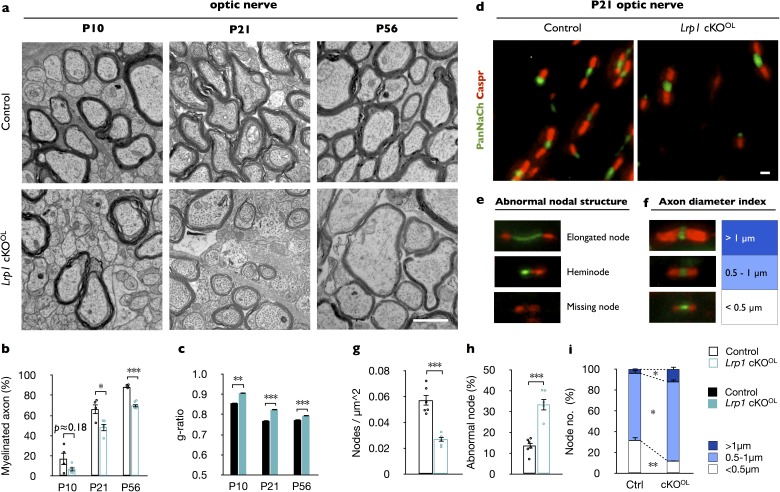
Lrp1 ablation in the OL-lineage leads to hypomyelination and nodal defects.(a) Ultrastructural images of optic nerve cross-sections from P10, P21, and P56 control and Lrp1flox/flox;Olig2-Cre conditional knockout mice (Lrp1 cKOOL). Scale bar = 1 µm. (b) Quantification of myelinated axons in the optic nerve of Lrp1 control and cKOOL mice at P10, P21 and P56 (n = 4 mice per genotype for each three time point). (c) Averaged g-ratio of Lrp1 control and cKOOL optic nerve fibers from four mice per genotype for each of the three time points. At P10, n = 488 myelinated axons for control and n = 261 for cKOOL; at P21, n = 1015 for control and n = 997 for cKOOL; at P56, n = 1481 for control and n = 1020 for cKOOL mice. (d) Nodes of Ranvier in P21 optic nerves of Lrp1 control and cKOOL mice were labeled by anti-PanNaCh (green, node) and anti-Caspr (red, paranode) staining. Scale bar = 1 µm. (e) Nodal defects detected include elongated node, heminode, and missing node (Na+ channels absent). (f) Representative nodal staining categorized by axon diameter. (g) Quantification of nodal density in P21 Lrp1 control (n = 6) and cKOOL (n = 5) optic nerves. (h) Quantification of abnormal nodes of Ranvier in Lrp1 control (n = 6) and cKOOL (n = 5) optic nerves. (i) Quantification of nodes associated with large (>1 μm), intermediate (0.5–1 μm), and small caliber fibers (<0.5 μm) in Lrp1 control (n = 6) and cKOOL (n = 5) optic nerves. Results are shown as mean ±SEM, *p<0.05, **p<0.01, and ***p<0.001, Student’s t-test. For a detailed statistical report, see Figure 2—source data 1.10.7554/eLife.30498.009Figure 2—source data 1.Raw data and detail statistical analysis report.